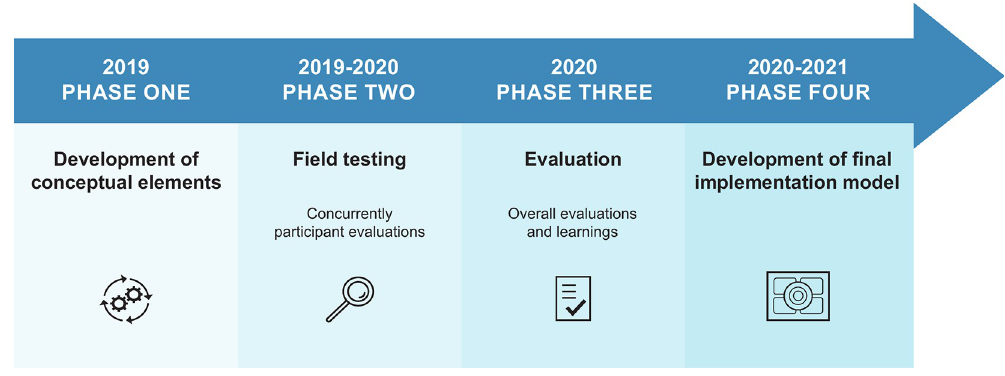
Fig 3. Timeline with